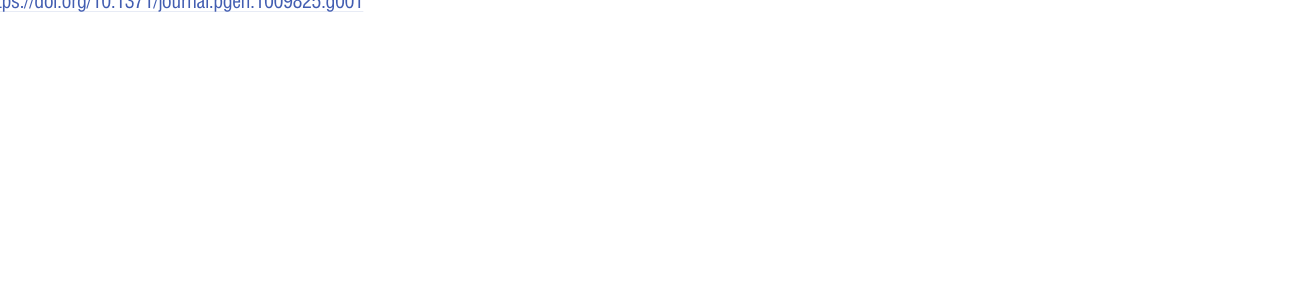
PLOS Genetics | https://doi.org/10.1371/journal.pgen.1009825 September 28, 2021 2 /